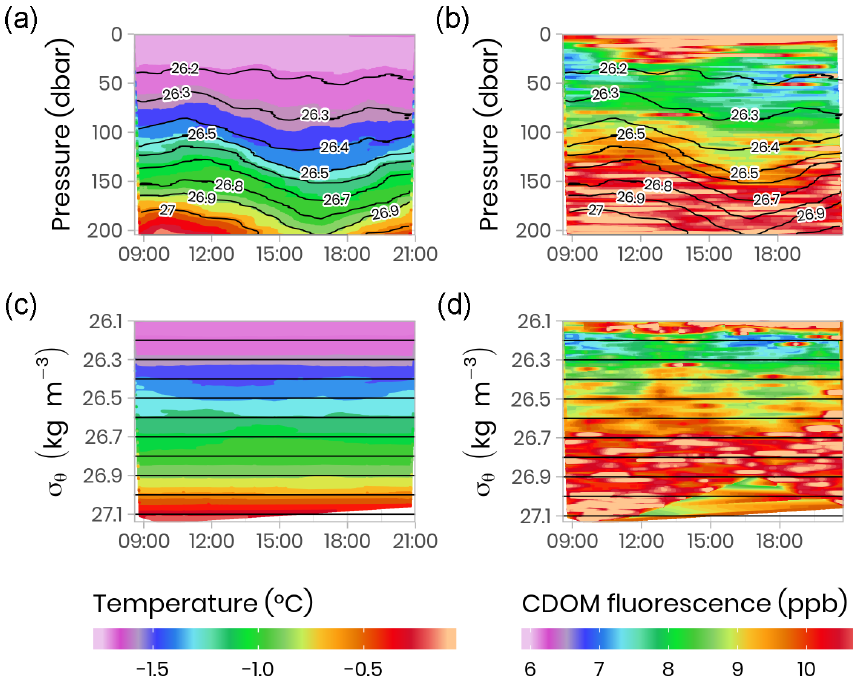
Figure 4. Temporal evolution of physical (temperature) and bio-optical (CDOM fluorescence) variables with superimposed lines of potential density anomaly ( σ θ , kgm − 3 ) during a 13h tidal cycle. Surface tidal height vs. time at Qikiqtarjuaq is shown in blue. (a, b) Plotted vs. pressure coordinates (equivalent to depth in meters). (c, d) The same data plotted vs. potential density anomaly σ θ coordinates (kgm − 3 ). The tidal survey was performed on 9 June 2015.